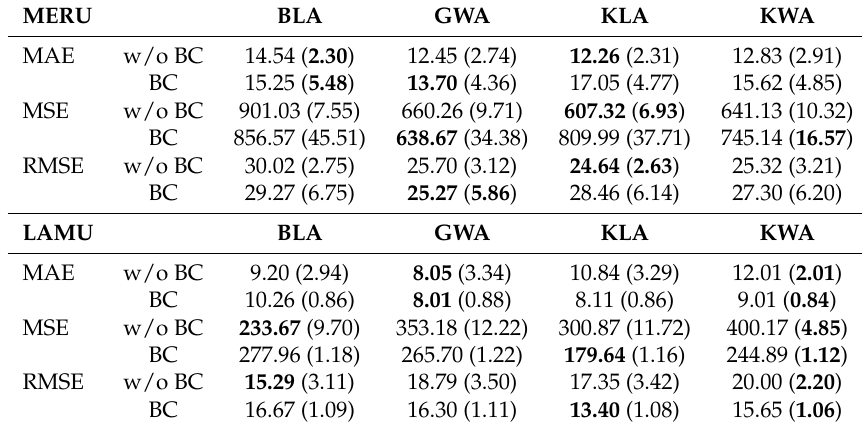
Table 3. Performance statistics assessed for P and T ( T is given in brackets) for MERU and LAMU stations without and with bias correction, conducted for the independent validation period (2011–2014). Smallest values are